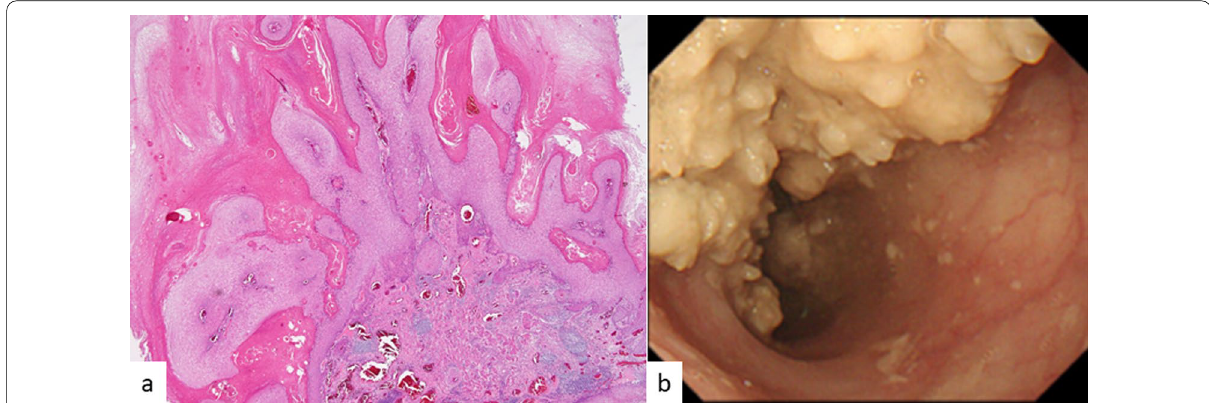
Fig. 1 Images from gastrointestinal endoscopy and a histological biopsy specimen. a Hematoxylin and eosin staining shows malignant papillary carcinoma composed of keratinized and well-differentiated squamous cell carcinoma. b Gastrointestinal endoscopy shows a white, plaque-like, ulcerative